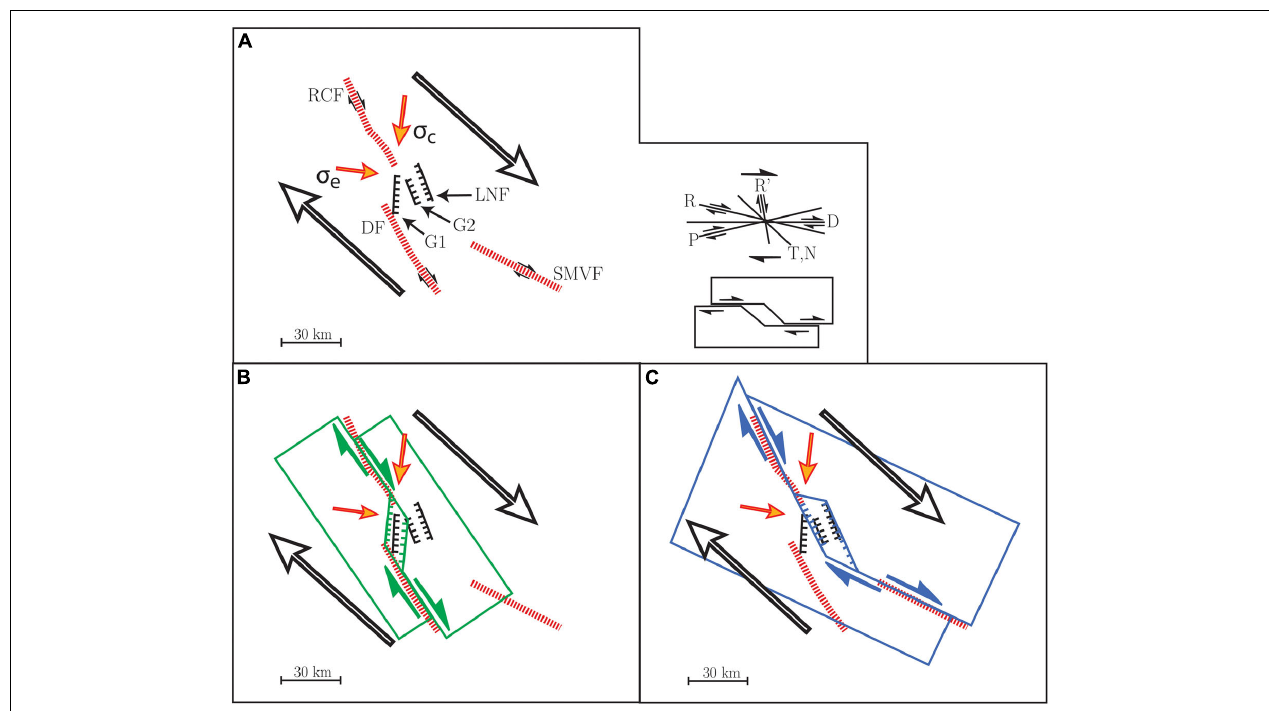
FIGURE 14 | Conceptual model for San Diego Bay pull-apart basin. (A) Model parameters, see Figure 13 for explanation. (B) Conceptual model for Group-1 faults in a Rose Canyon-Descanso fault stepover. (C) Conceptual Model for Group-2 and La Nacion faults in a Rose Canyon-San Miguel-Vallecitos fault stepover. RCF, Rose Canyon fault; DF, Descanso fault; SMV, San Miguel-Vallecitos fault; G1, Group 1; G2, Group 2; LNF, La Nacion fault zone.